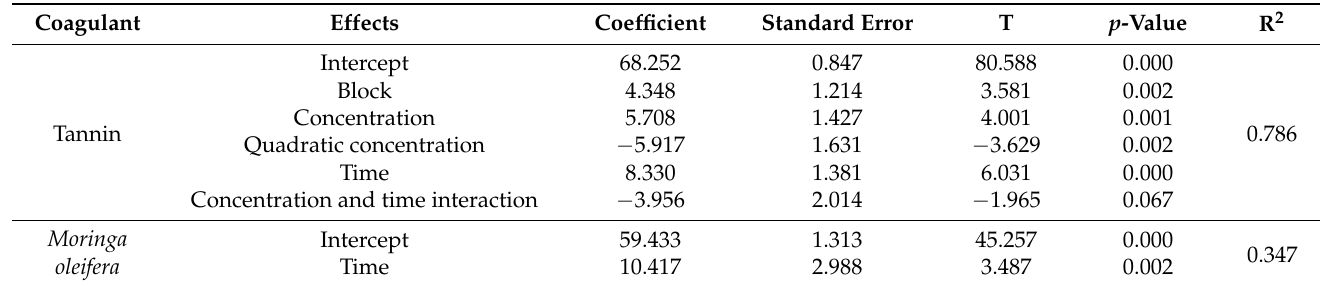
Table 7. Significant effects for the chemical oxygen demand (COD) parameter for coagulation, flocculation, and sedimentation (C/F/S) process using tannin and Moringa oleifera in the presence and absence of